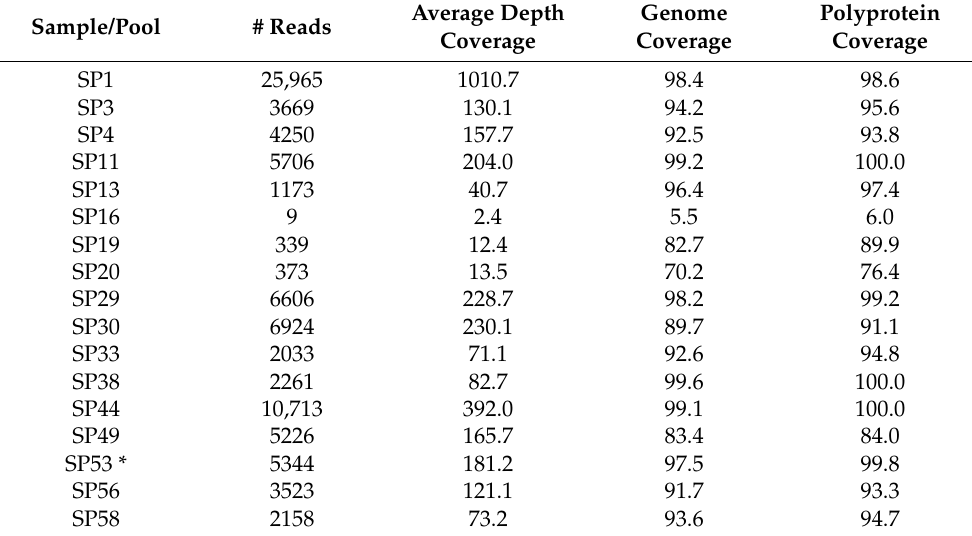
Table 3. Summary of HPgV analysis. Estimates were obtained using accession U44402 as the reference sequence. * This pool consists of two different HPgV isolates, and individual estimates cannot be independently